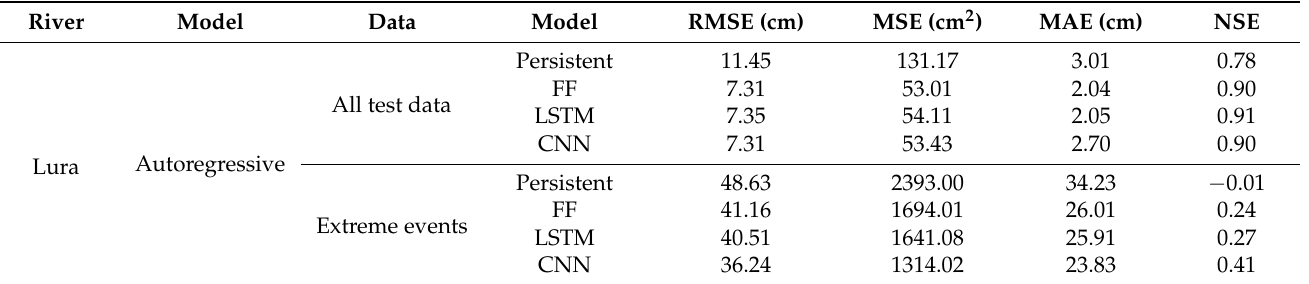
Table 5. The performance of the Lura River’s autoregressive models: average value of the evaluation metrics over the entire test dataset and flood events only.